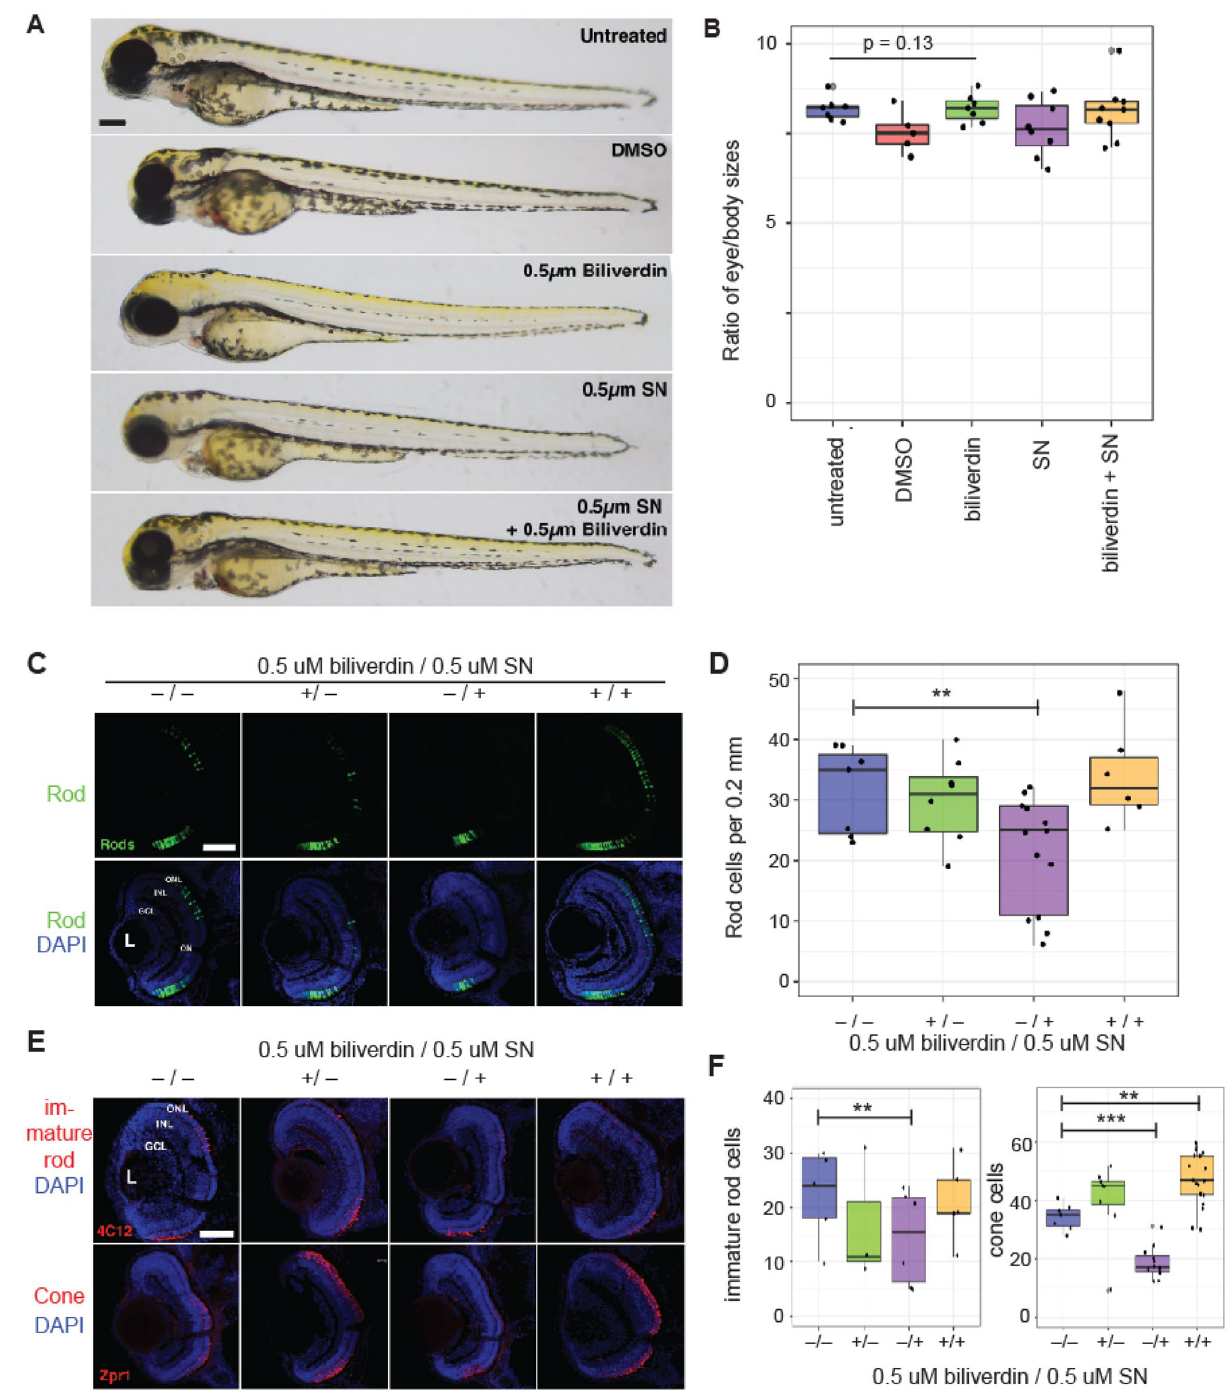
Figure 4. Biliverdin contributes to retinal development in zebrafish larvae. ( A , B ) Biliverdin and sulconazole at the tested concentrations (0.5 μM each) did not affect the overall development of zebrafish larvae. ( A ) Whole mount images of 3 dpf zebrafish larvae. ( B ) Quantification of the eye and body size ratios. ( C ) Fluorescence microscopic images of 3 dpf zebrafish larvae (from left to right) without any treatment, with 0.5 μM biliverdin, with 0.5 μM sulconazole nitrate, and with both biliverdin and sulconazole nitrate (top: rod photoreceptor cells, bottom: overlay of rod photoreceptor cells and DAPI-stained cells). ( D ) Quantification of rod photoreceptor cells in zebrafish larvae (3 dpf) grown in different conditions (** p = 0.00369). ( E ) Fluorescence microscopic images of zebrafish larvae (top) immunolabeled with the 4C12 antibody (which detect immature rod photoreceptors) and (bottom) red-green cones immunolabeled with the Zpr-1 antibody. Nuclei were counterstained with DAPI. ( F ) Quantification of immature rods and red-green cones (*** p < 10 −5 ). ONL, outer nuclear layer; INL, inner nuclear layer; GCL, ganglion cell layer. Scale bars, 0.1 mm in A; 0.05 mm in C , E